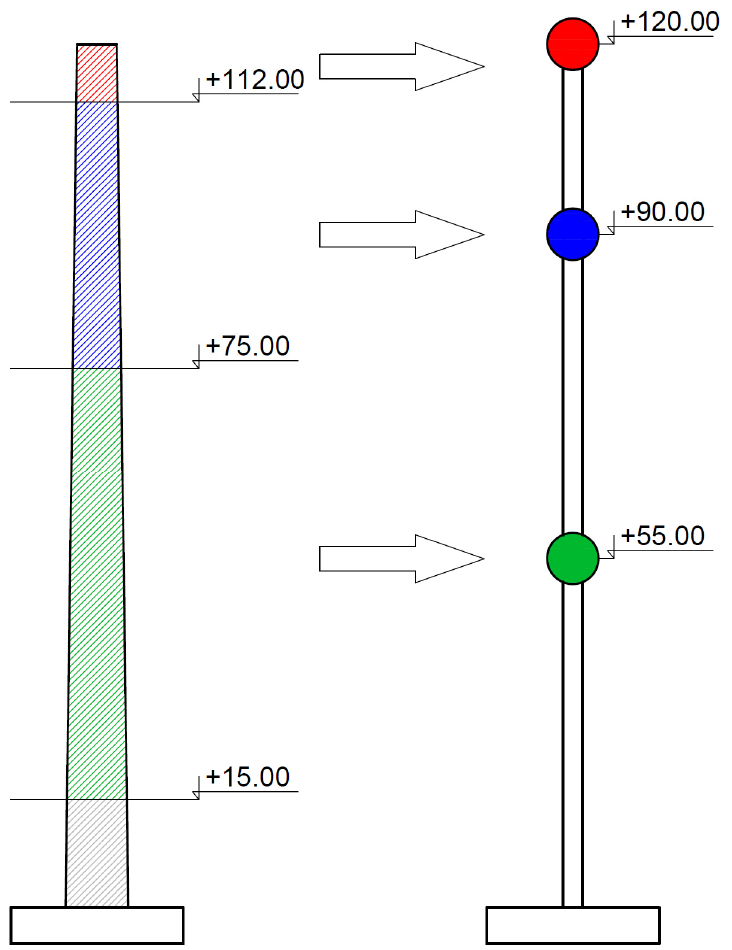
Figure 13. The scheme for determining additional masses and their arrangement. Table 5. The distribution of the brick lining mass of the chimney (the prototype), and the arrange- ment of the additional masses of the model.